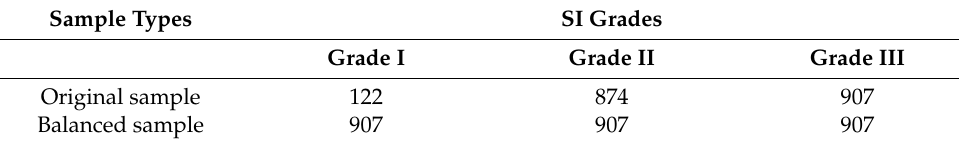
Table 4. The number of samples before and after data